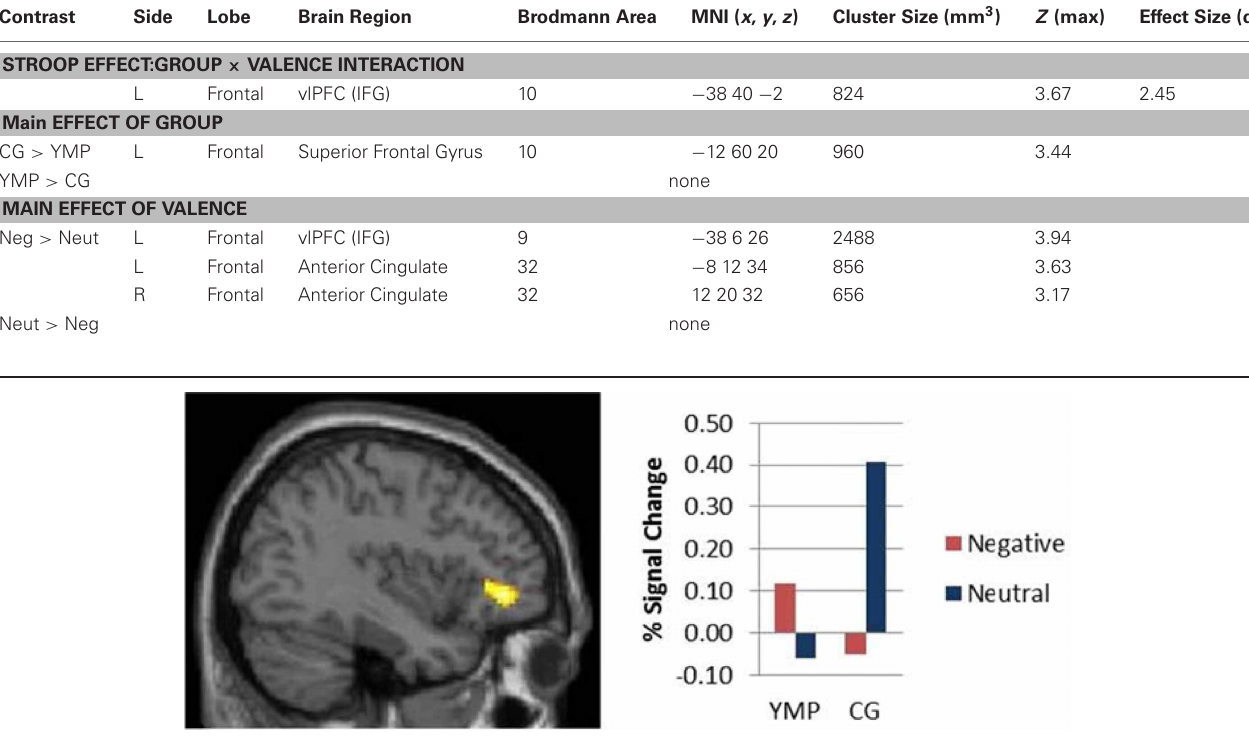
FIGURE 3 | fMRI contrast of the Group × Distractor Valence interaction on Stroop-BOLD response. Among Yoga Meditation Practitioners (YMP), Stroop-BOLD was greater during negative, as compared to neutral